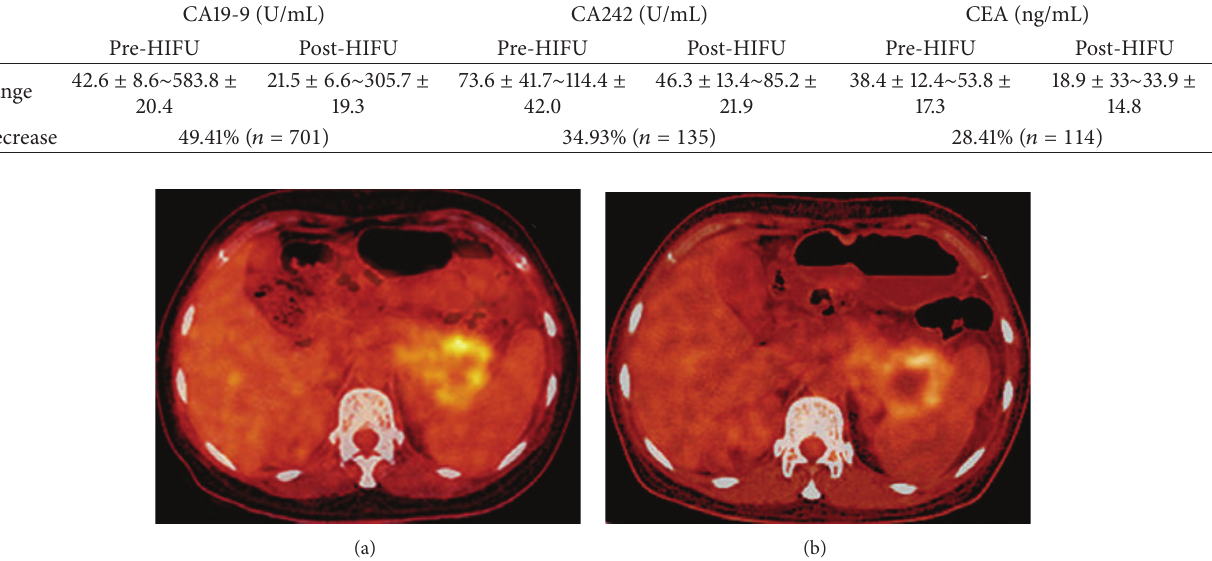
Figure 8: A PET-CT scan made (a) before HIFU demonstrates a SUVmax of 7.5 g/mL and (b) 3 months after HIFU demonstrates coagulative necrosis inside the tumor and the decreased SUVmax of 5.3 g/mL (used with permission [21]).